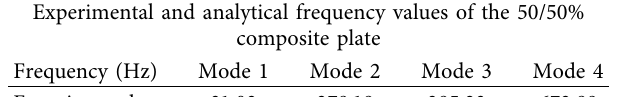
Coefficient ξ � 0.036. From Figure 14(c), for the first cycle n � 1, maximum amplitude X 1 � 0.000253, minimum am-